Question: In a single sentence, describe what this figure presents.
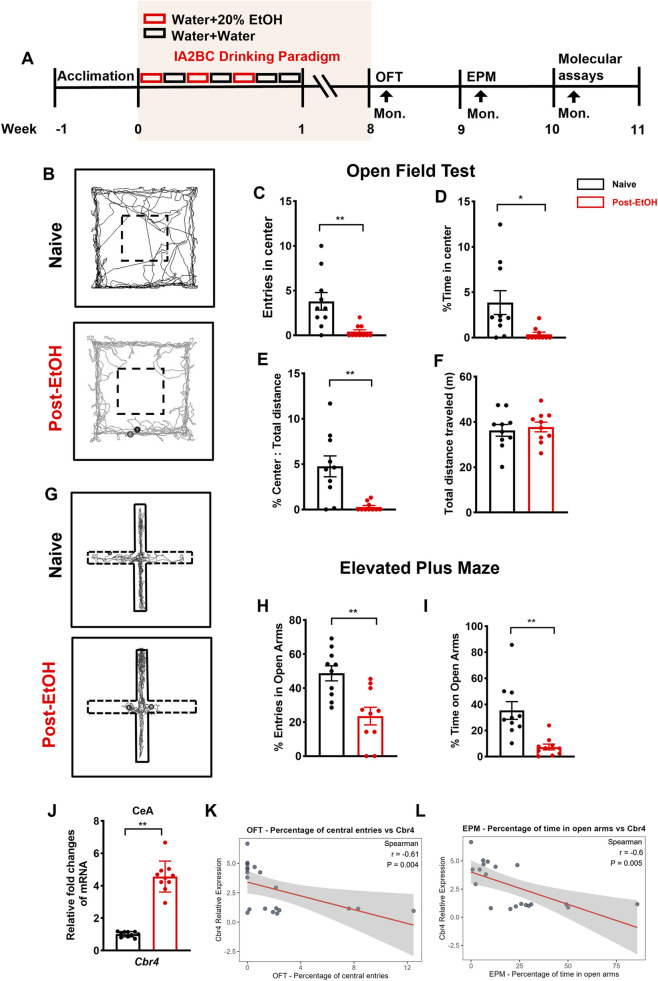
Answer: Behavioral tests, RT-qPCR validation of key genes, and correlation analysis in the CeA. (A) The schematic diagram shows the experimental timeline. gradually escalating from the 1st to the 24th session and reaching stable levels (* p < 0.05, ** p < 0.01 vs. 1st session, one-way RM ANOVA followed by Bonferroni post-hoc test). (B) Representative trajectory map of the Open Field Test (OFT) in Naïve and Post-EtOH rats. (C–F) Comparison of four key indicators of the OFT between the two groups: Post-EtOH rats showed elevated anxiety-like behaviors compared with Naïve rats (* p < 0.05, ** p < 0.01 vs. Naïve group, Unpaired t-test). (G) Representative trajectory map of the Elevated Plus Maze (EPM) in Naïve and Post-EtOH rats. (H–I) Comparison of two key indicators of the EPM between the two groups: Post-EtOH rats exhibited increased anxiety-like behaviors compared with Naïve rats (* p < 0.05, ** p < 0.01 vs. Naïve group, Unpaired t-test). (J) RT-qPCR validation of the key candidate gene in the CeA: Cbr4 showed significant expression differences between the Naïve and Post-EtOH groups. ( p < 0.05, Unpaired t-test). (K–L) Pearson correlation analysis between the key gene Cbr4 and core behavioral indicators: (K) Correlation between Cbr4 and the percent of time in center (OFT); (L) Correlation between Cbr4 and the percent of time in the open arms (EPM), both showing a significant negative correlation ( p < 0.05).